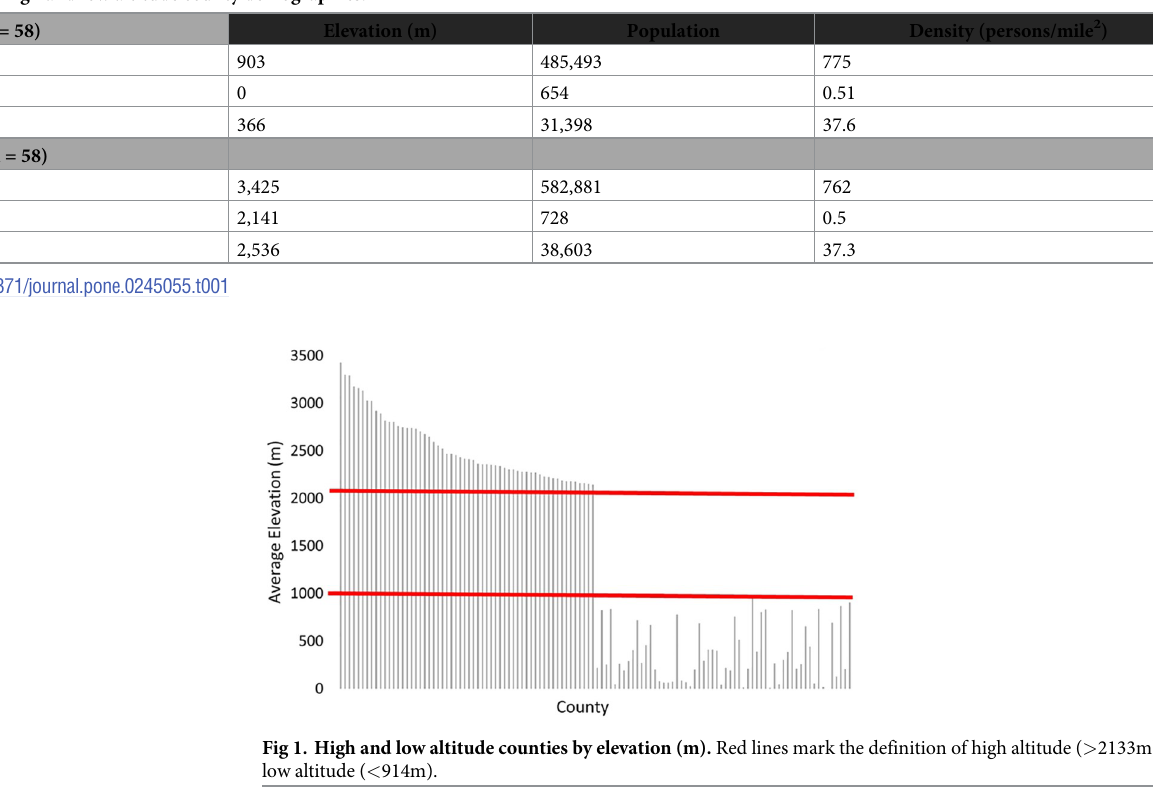
Table 1. Matched high and low altitude county demographics.